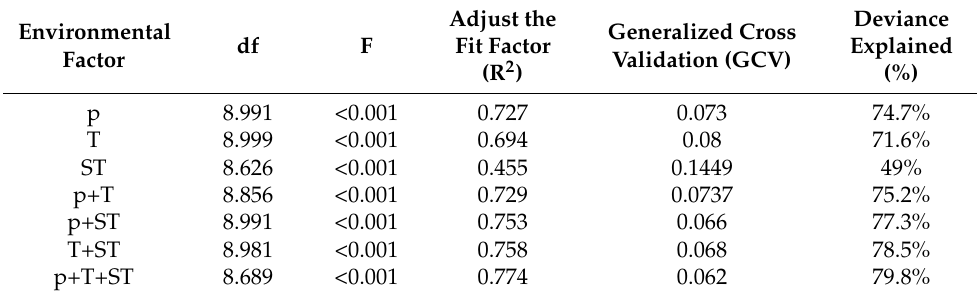
Table 2. The result of GAM of variables to build the models for the beetle richness. Variable codes as in Table